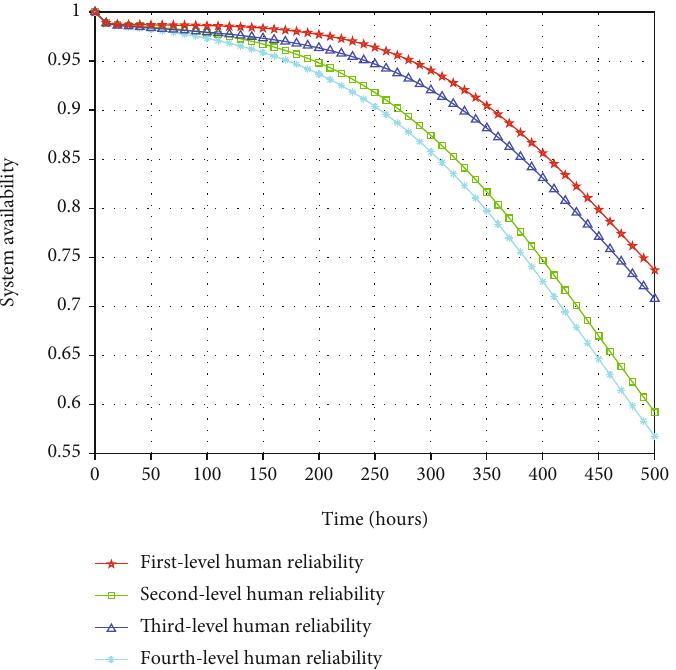
Figure 20: System availability trajectory with improved failure and repair